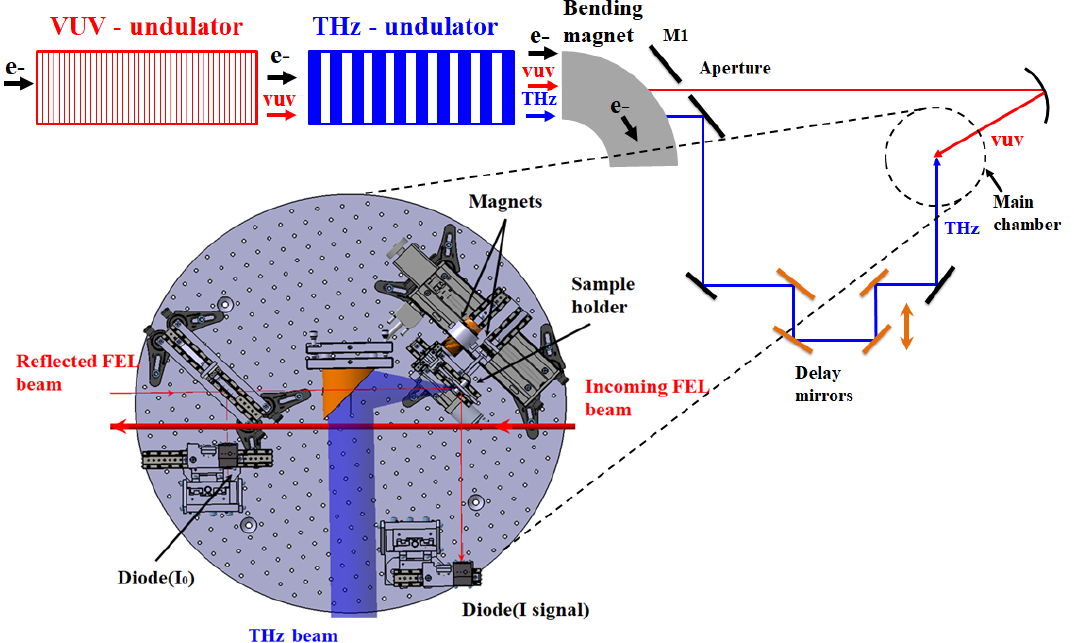
Figure 2. Layout of the experimental setup. XUV probe pulse (red) and THz pump pulse (blue) are produced by the XUV undulator and the THz undulator respectively. The zoom on the main chamber shows the THz beam focused onto the sample by a parabola and the probe beam going through the chamber before coming back focused onto the sample by a spherical mirror (not shown). Two APDs are used to measure the intensity of the incoming probe beam (measuring the partial reflection on a Si 3 N 4 window) and the signal reflected by the